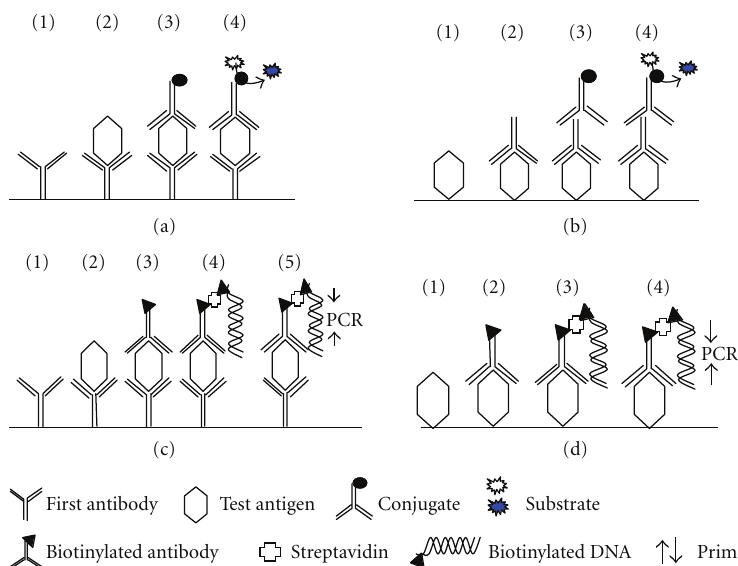
Figure 1: Schematic of ELISA and immuno-PCR for detecting circulating antigen in serum. (a) Sandwich ELISA. (1) Plate is coated with a capture antibody; (2) serum sample is added, and any antigen present in the serum binds to the capture antibody; (3) detecting antibody conjugate is added and binds to the antigen; (4) substrate is added, and is converted by the enzyme to a detectable form. (b) Direct ELISA. Plate is coated with diluted serum containing antigen; (2) detecting antibody is added, and binds to antigen; (3) enzyme-linked secondary antibody is added, and binds to detecting antibody; (4) substrate is added and is converted by the enzyme to a detectable form. (c) Capture immuno-PCR. (1) Plate is coated with capture antibody; (2) serum sample is added; (3) biotinylated detecting antibody is added and binds to antigen; (4) Streptavidin and biotinylated reporter DNA are added, and the biotinylated antibody and biotinylated reporter DNA are linked by streptavidin; (5) Primers and PCR components are added and PCR or real-time PCR undertaken to quantify antigen. (d) Non-capture immuno-PCR. Serum sample is coated on the plate and the remainder of the steps are as for the capture-immuno-PCR